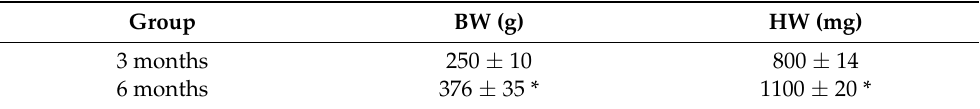
Table 1. Basic biometric parameters of